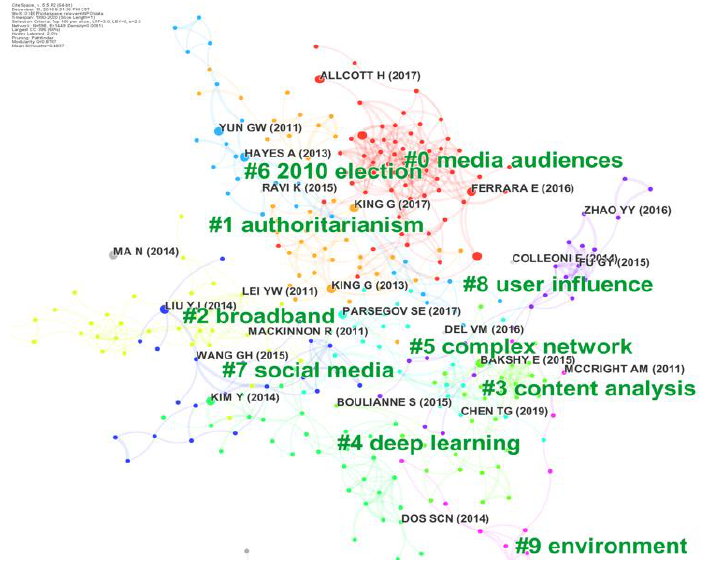
Figure 10. The reference co-citation analysis in NPO